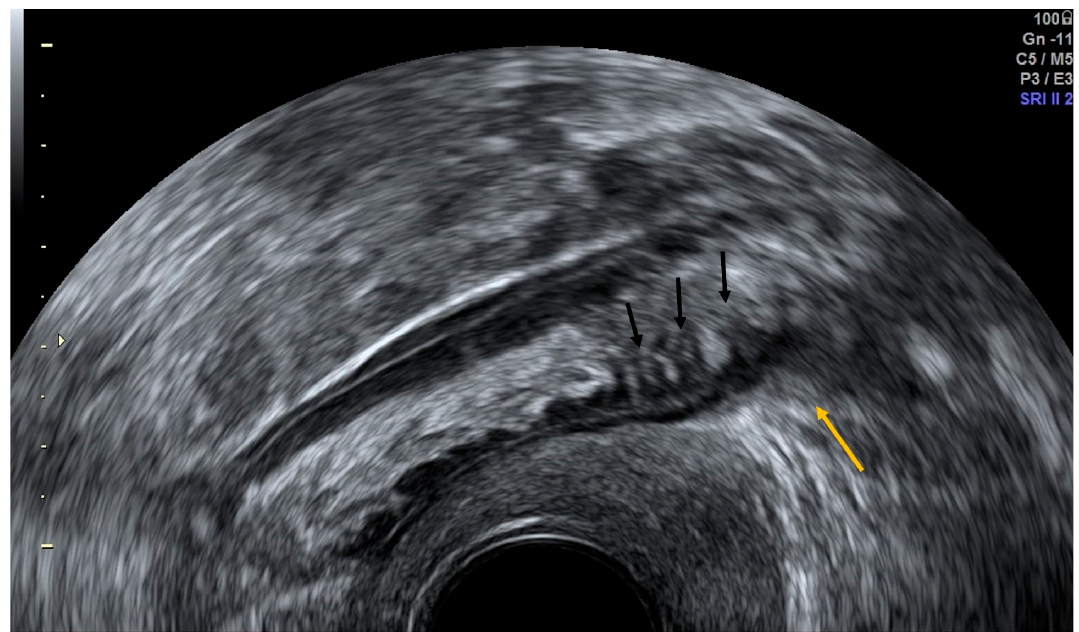
Figure 8. Transvaginal grayscale ultrasound in a patient with acute diverticulitis shows a hyperechoic image arising from the colonic wall with a hypoechoic rim representing wall thickening of the inflamed diverticulum (yellow arrow) and minimal wall thickening of the colon (black arrows).